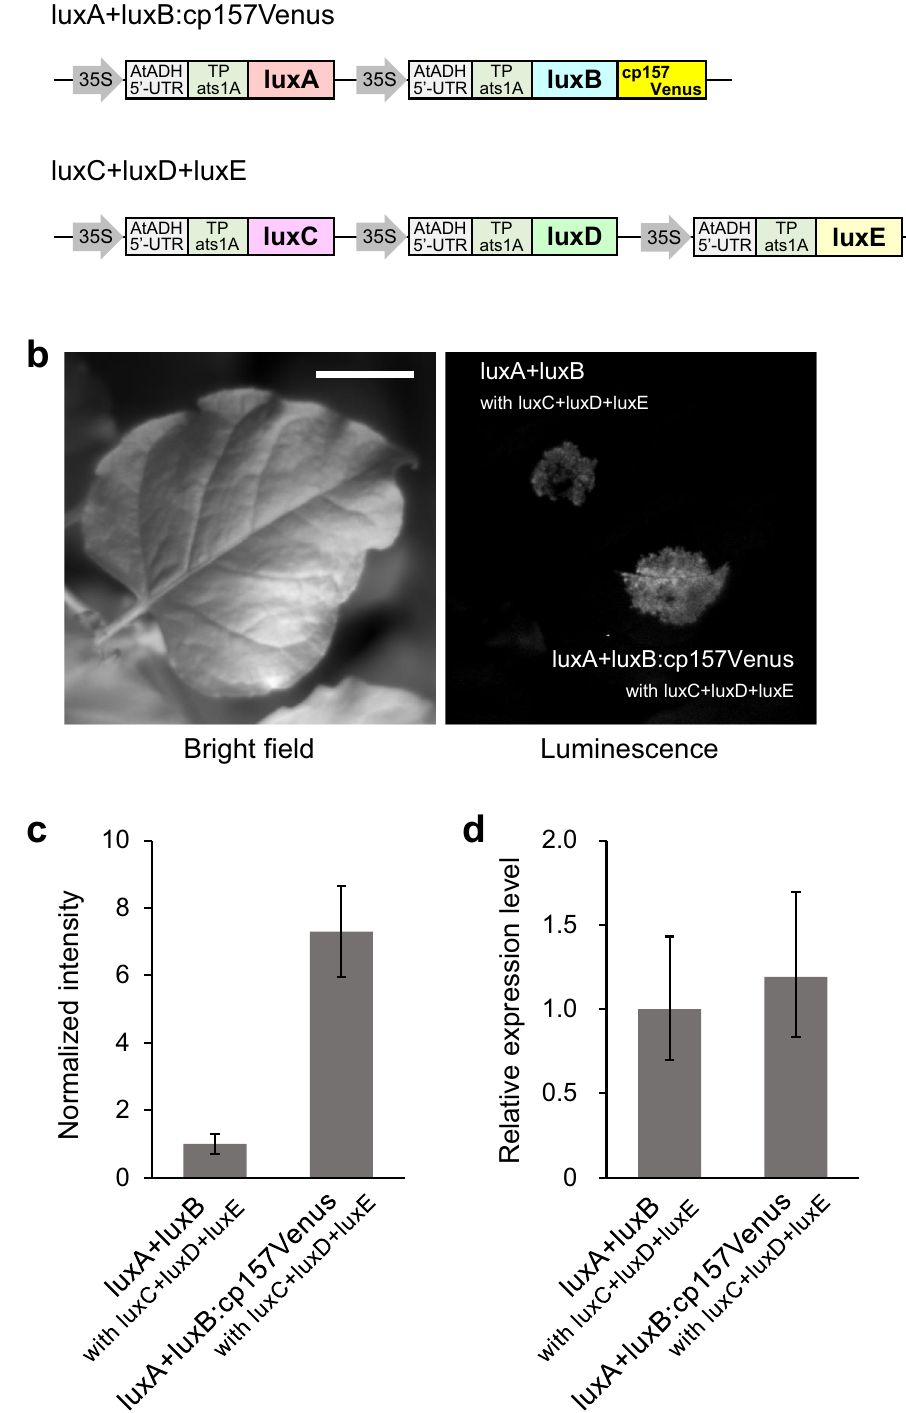
Figure 5. Autobioluminescence of N. benthamiana leaves expressing lux genes. ( a ) Schematic representation of expression constructs containing lux genes in pRI201-AN vector. ( b ) Luminescence image of the leaf cotransfected with the indicated constructs by Agrobacterium infiltration. The exposure time for the luminescence image was 10 s. Scale bar, 2 cm. ( c ) Luminescence intensities of leaf discs cut from the Agrobacterium -infiltrated regions. Data are means ± SD of three different leaves. ( d ) Relative quantitation of luxB and luxB:cp157Venus expression. The transcript level was probed with luxB primers. Results were normalized by PP2A gene expression. Values are calculated by ΔΔC T from three biological